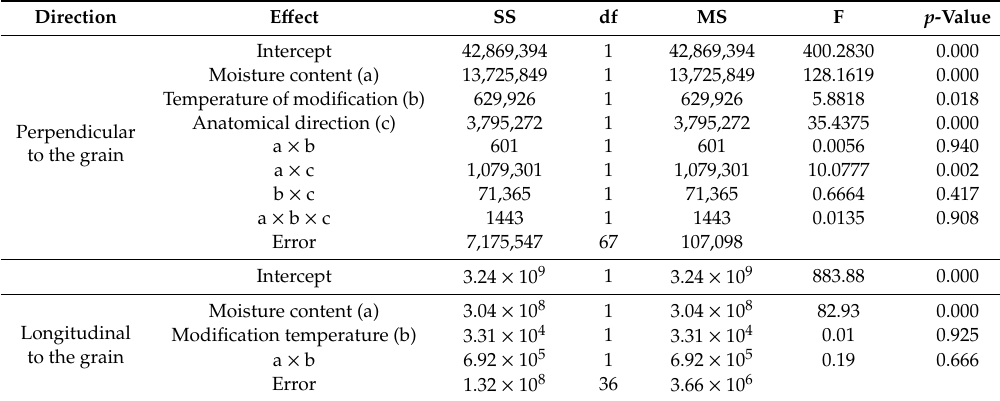
Table 2. Analysis of variance taking into account the e ff ect of moisture content, modification temperature and the anatomical direction on the modulus of elasticity (MOE) perpendicular and longitudinal to the grain for thermally-modified ash ( Fraxinus excelsior L.) wood. Direction E ff ect